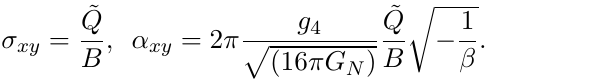
Figure 1 . Result of RG (cid:13)ow for the case (cid:13) = needs to be B (cid:29) Q in order for the coupling Z ( (cid:30) ) to be well-approximated by an exponential near the horizon. We chose B=Q = 100 for this plot. The horizon is at ~ r = 1, the boundary at ~ r =